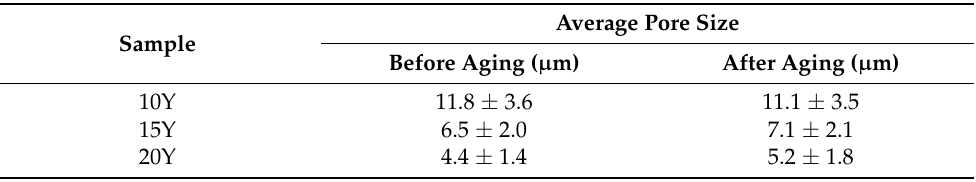
Figure 6. Exemplary stress–strain curves for sintered 10Y, 15Y, and 20Y samples for constant load rate of 1 N s − 1 .